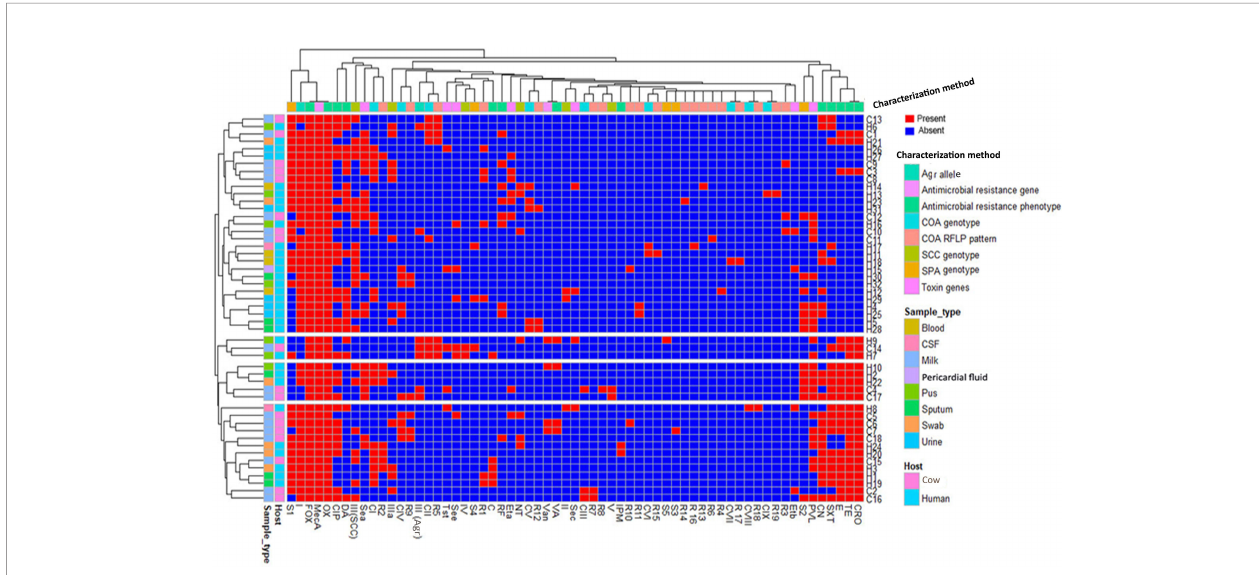
FIGURE 6 | Heatmap showing the hierarchical clustering and overall distribution of ST239-MRSA strains based on their genotypes and antimicrobial resistance and toxin gene pro fi les. Red and blue colors refer to presence and absence of a particular feature, respectively. The dendrogram represents the hierarchical clustering of the strains and various features. Different categories of characterization methods, sample types, and hosts are color-coded on the right of the heatmap. CIP, cipro fl oxacin; RF, rifamycin SV; TE, tetracycline; CRO, ceftriaxone; E, erythromycin; C, chloramphenicol; VA, vancomycin; DA, clindamycin; SXT, trimethoprim ‐ sulfamethoxazole; CN, gentamicin; IPM, imipenem; CI – CIX, coagulase genotypes; R1 – R19, coa -RFLP patterns; SCC mec ( II , III , IV , and V ), staphylococcal cassette chromosome mec ; NT, non-typeable; agr ( I and III ), accessory gene regulator; S1 – S5, spa PCR products; van , vancomycin resistance gene; pvl , Panton – Valentine leucocidin; sea , see , and sec , staphylococcal enterotoxins A, B, and C; tst , toxic shock syndrome toxin; eta and etb , exfoliative toxins A and